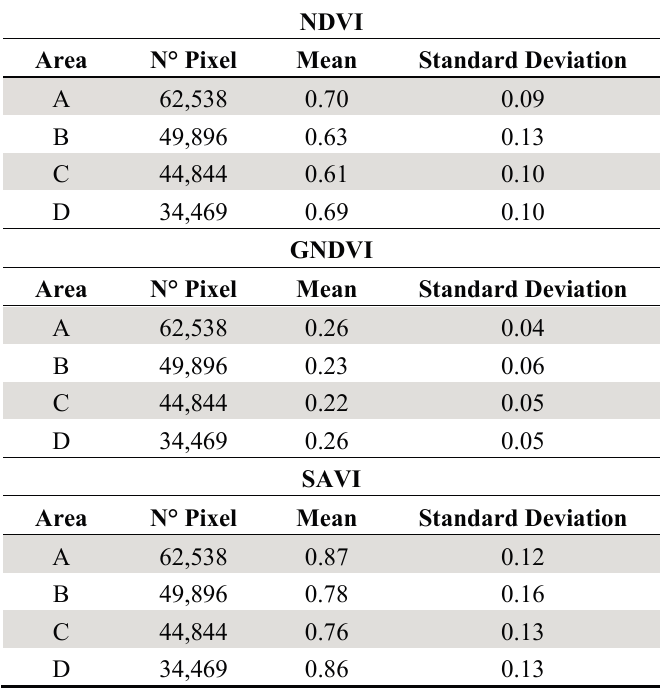
Table 5. Mean and Standard Deviation of sample areas A, B, C, and